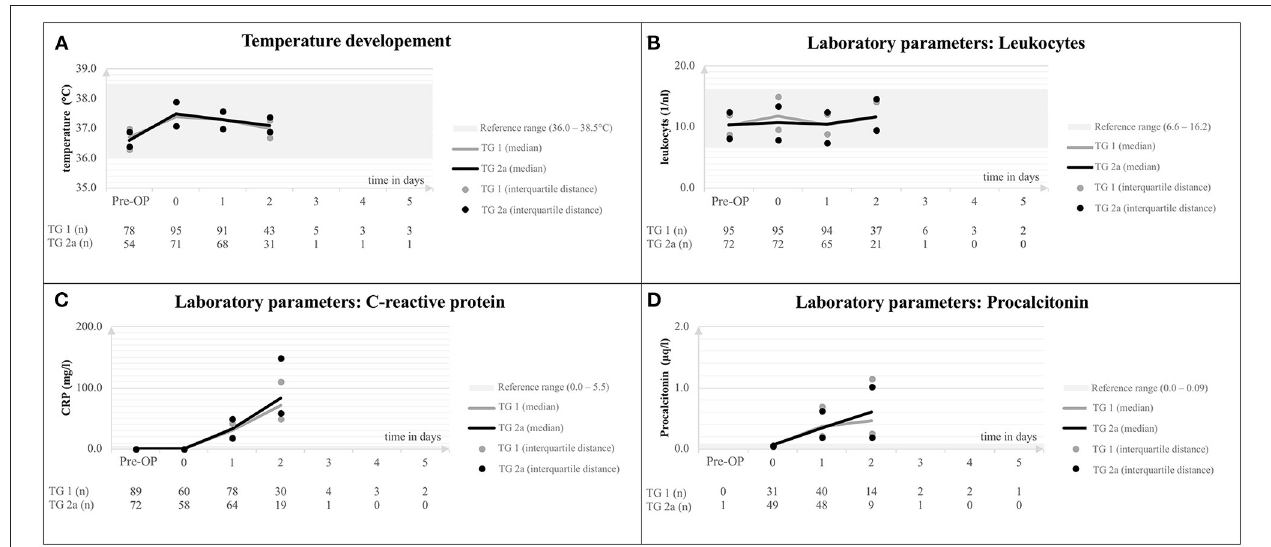
FIGURE 3 | Body temperature (A) , leukocyte counts (B) , C-reactive protein (C) , and procalcitonin (D) after craniosynostosis surgery compared between TG 1 and 2a. TG, treatment